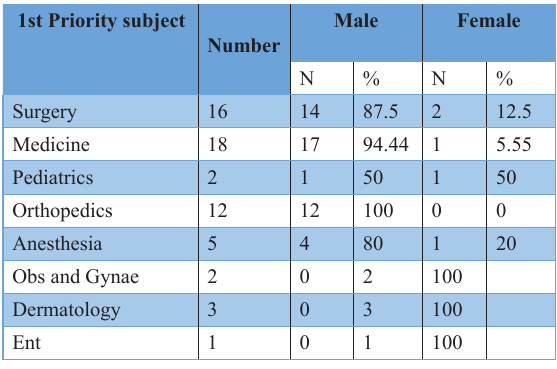
Table 7. Gender variation according to